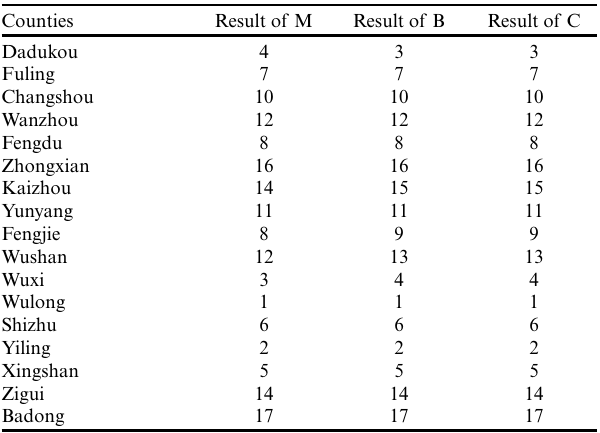
Table 8 . Results using the second centralized